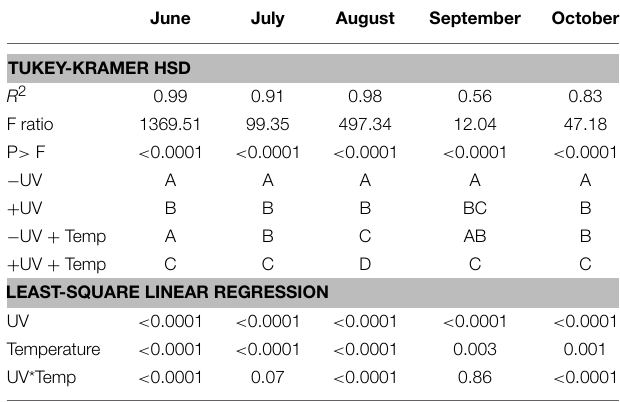
TABLE 2 | ANOVA testing for the response of NCP among treatments ( + UV, − UV; + UV + T; − UV + T) for each experiment